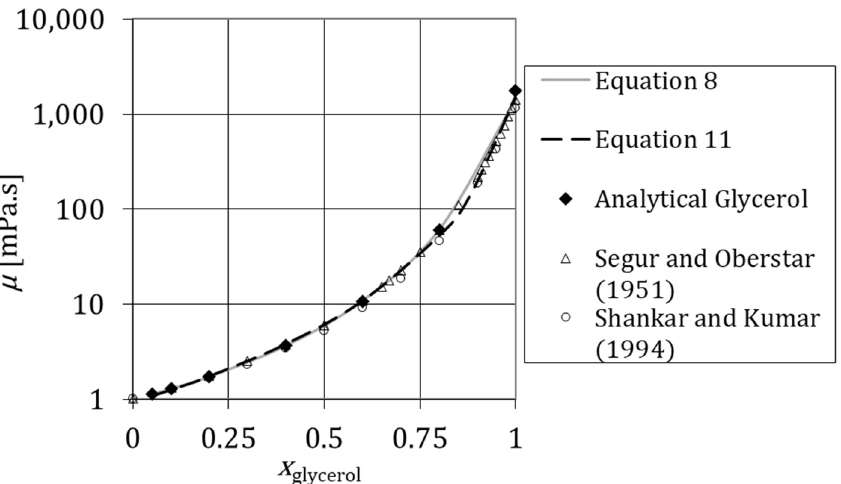
Figure 4. Variation of viscosity of aqueous solutions of glycerol with the mass fraction of glycerol at θ = 293.15 K measured experimentally (Analytical Glycerol) and the respective comparison with Equation (8), Equation (10) and the data in the literature [46,47].